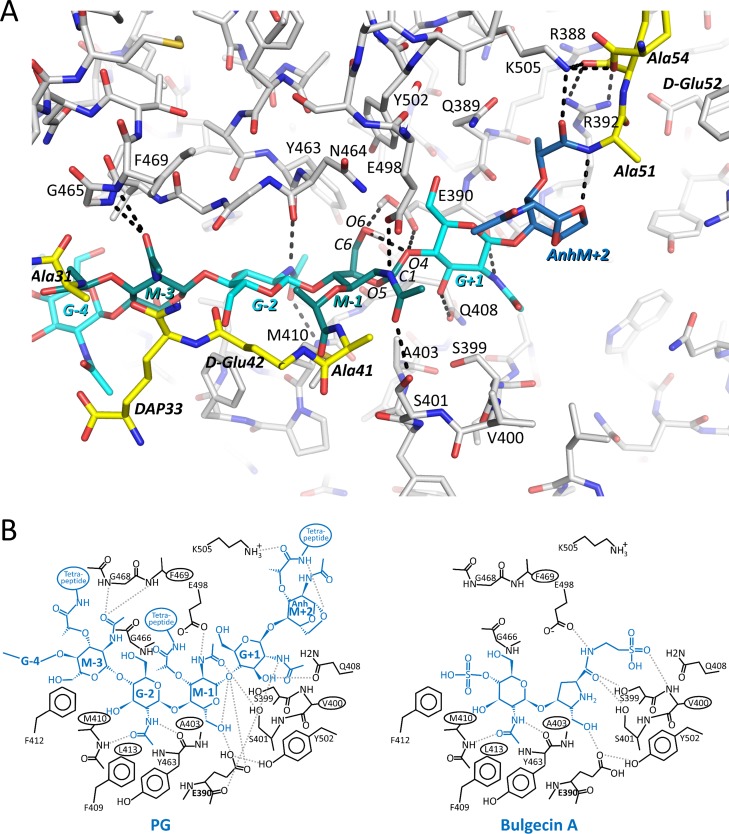
MD snapshot of the 5 disaccharide unit PG strand in the active site of Cj0843 in the substrate-binding mode.A The snapshot is at time point 57.82 ns of the protonated E390 MD run 3. The coloring and labeling of the PG strand are the same as in Fig 6. Hydrogen bonds are depicted as dashed black lines. MurNAc-1 (‘M-1’) is observed to be in a boat conformation. Hydrogen atoms for PG and protein are not depicted except for the hydrogens on the protonated side chain of E390 and on the O6 atom of MurNAc-1. B Schematic diagram of the PG strand interactions in the active site of Cj0843 (left, from 57.82 ns time point) compared to the crystal structure of bulgecin A bound in the active site (right).